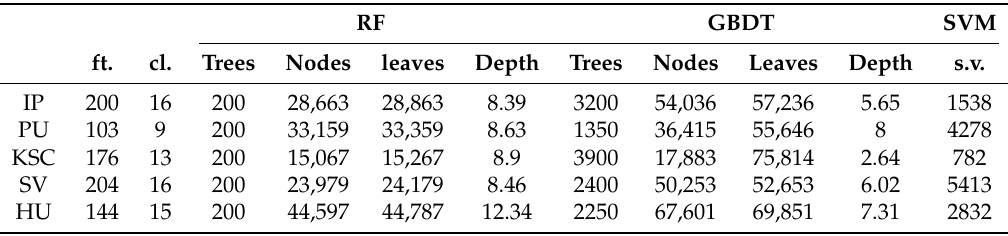
Table 4. Final configurations of random forest (RF), gradient boosting decision Trees (GBDT) and support vector machine (SVM)